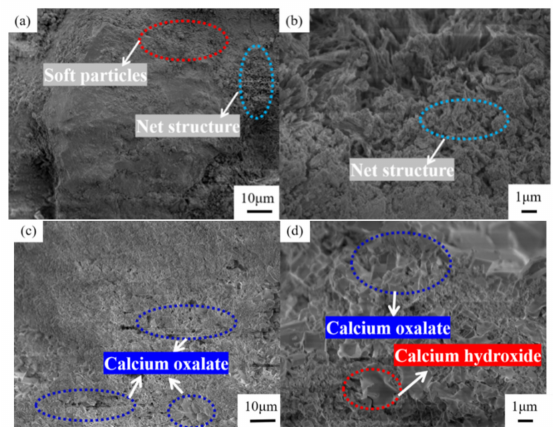
Figure 13. Microstructure of steel slag surface: ( a , b ) untreated, ( c , d )